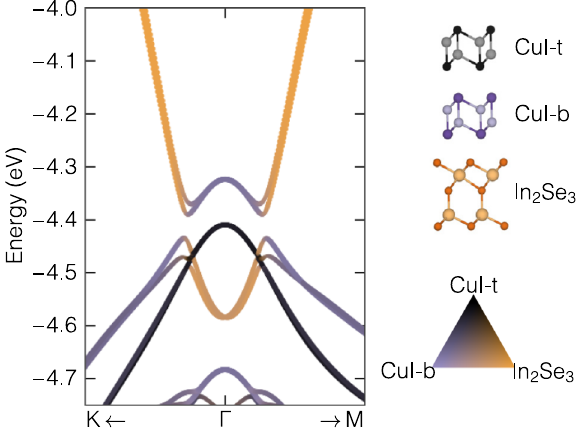
Fig. 8 Band structure of In 2 Se 3 -bilayer CuI. Energy bands around the Brillouin zone center for a heterostructure comprising mono- layer In 2 Se 3 and bilayer CuI (lateral view on the right). The color coding represents the layer contribution to electronic states, with orange denoting In 2 Se 3 , violet the bottom CuI closer to the ferroelectric layer, and black the upper CuI. A band inversion between the conduction band of In 2 Se 3 and the valence bands of CuI is still present, with a strong hybridization between In 2 Se 3 and the bottom CuI giving rise to a topological gap, while the valence band of the top CuI layer (black) is largely